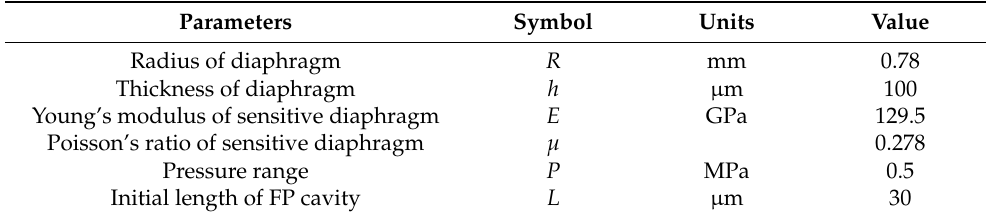
Table 1. The parameters of fiber-optic Fabry–Perot pressure sensor.